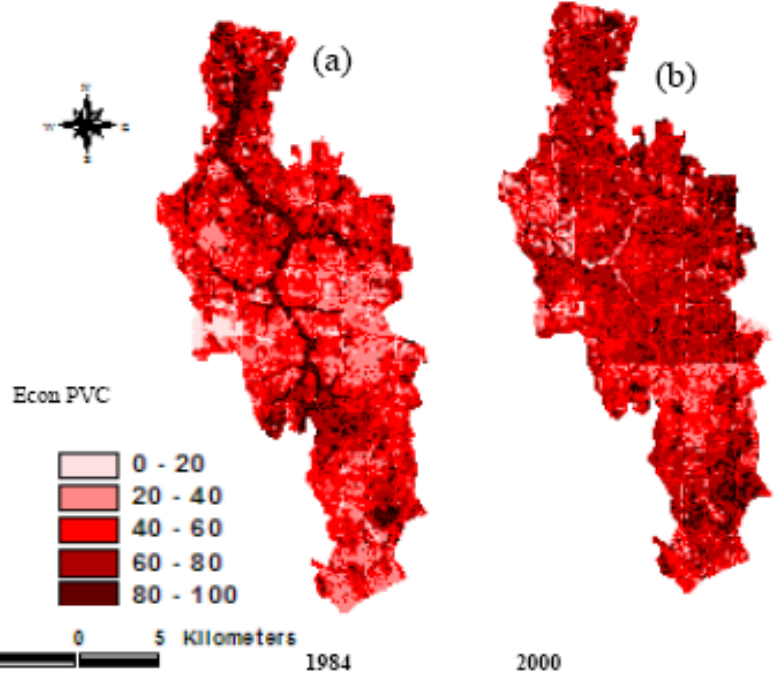
Figure 6. Percent vegetation cover for Econlockhatchee River sub-basin (Econ sub-basin) in